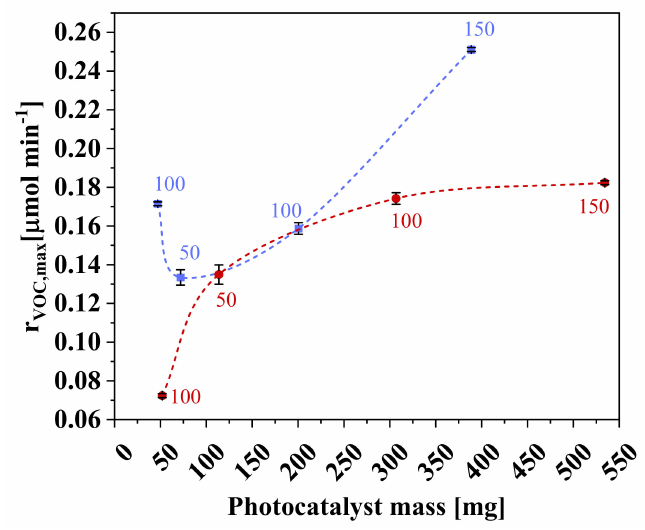
Figure 9. Maximum conversion rate of n -decane (r VOC,max ) as a function of photocatalyst mass, with ( (cid:4) ) and without ( • ) use of pore-forming agent (numbers indicate wet thickness, in microns). Conditions: irradiation intensity = 245.5 W m − 2 ; C VOC,feed = 78.8 ppm; Q feed = 150 cm 3 min − 1